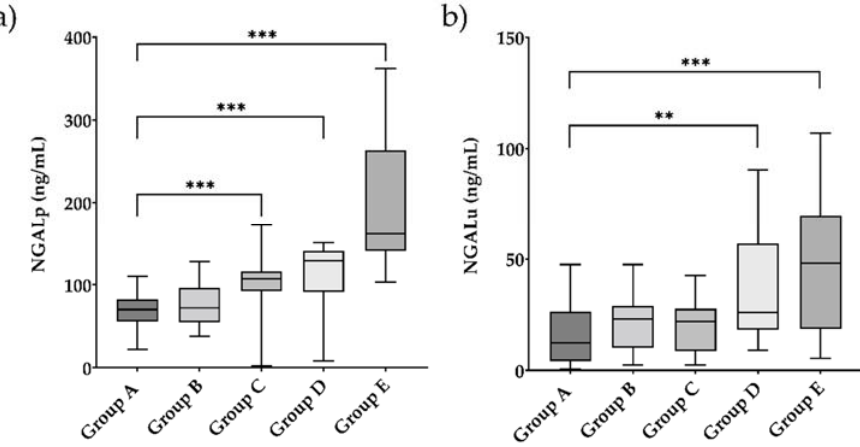
Figure 1. Plasma NGAL ( a ) and urine NGAL ( b ) levels in study population. ** p < 0.05; *** p < 0.001.